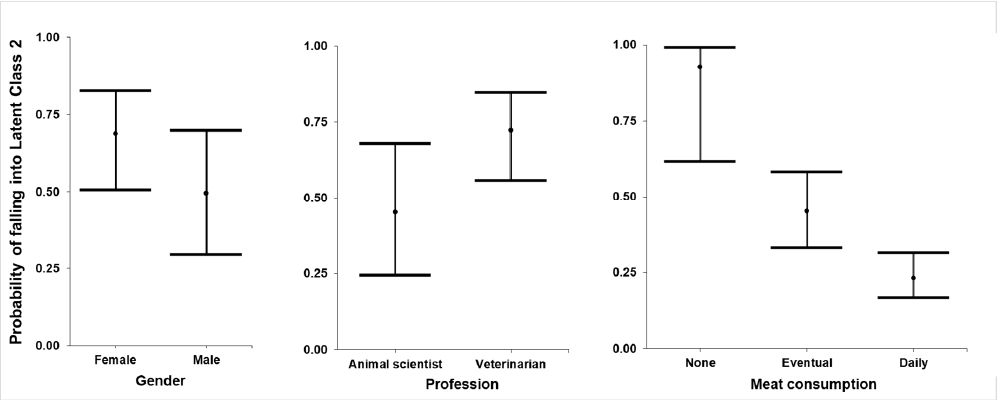
Figure 4. Adjusted respondent probability of falling into Latent Class 2 (pro-cell-based meat, 121 respondents) for the group of questions related to the environment, health, animal welfare and efficiency of production of conventional and cell-based meat, according to the responses to an online questionnaire by 209 Brazilian veterinarians and 63 animal scientists.